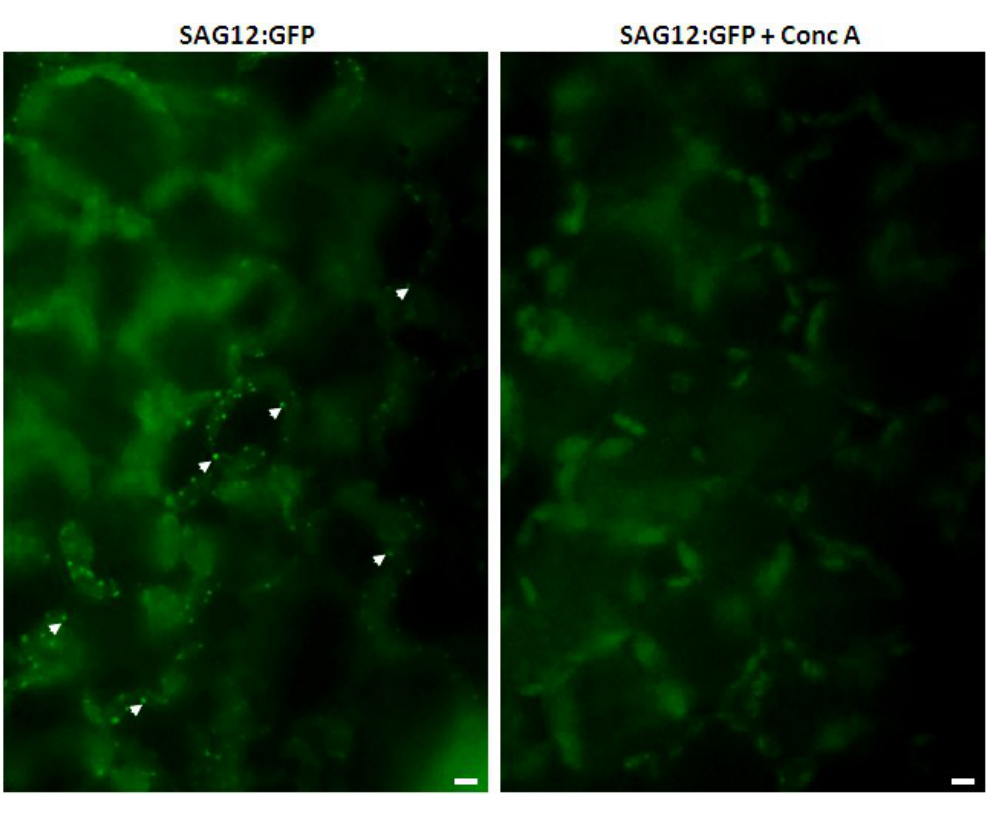
Figure 5. Disappearance of the SAG12-GFP signal due to concanamycin-A treatment. Detached tobacco leaves expressing SAG12 fused to GFP were induced to senesce by incubation in darkness for 3 days. Leaf disks were then excised and incubated in 1 µm concanamycin-A for 15 hours. Leaf pieces were observed directly with an epifluorescence microscope (Olympus BX61) fitted with an FITC filter. Note that the bright fluorescent vesicles (SAVs, a few representative SAVs are indicated by arrowheads) in the control, left panel, disappeared completely in leaf cells treated with concanamycin-A (right